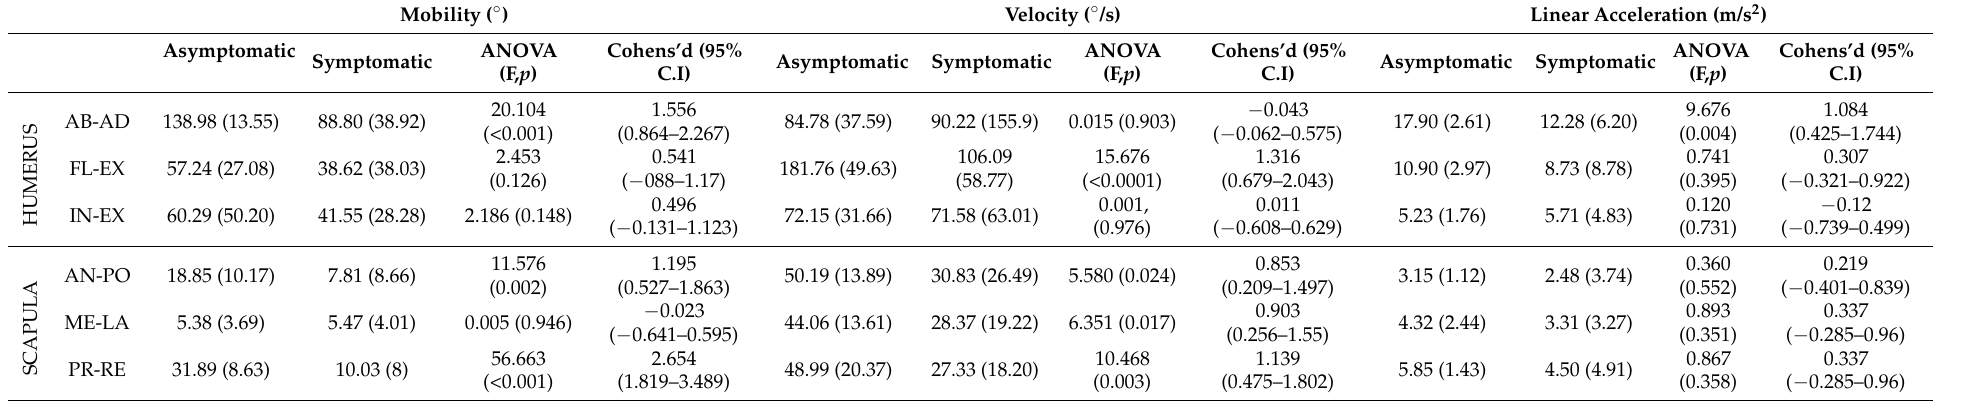
Table 2. Humerus and Scapula kinematics variables mean (SD) in Asymptomatic subjects and Symptomatic and difference between